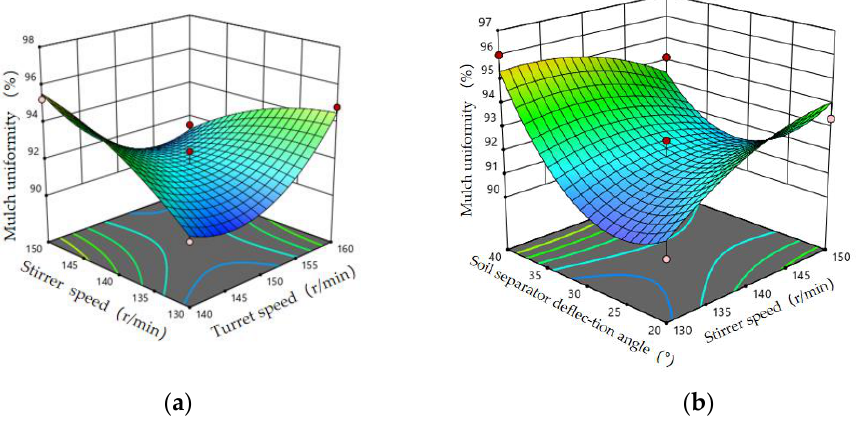
Figure 11. Effect of interaction factor on the mulching uniformity. ( a ) Influence of the interaction terms between turret speed and stirrer speed on the mulching uniformity. ( b ) Influence of the interaction terms of Stirrer speed and soil separator deflection angle on the mulching uniformity.